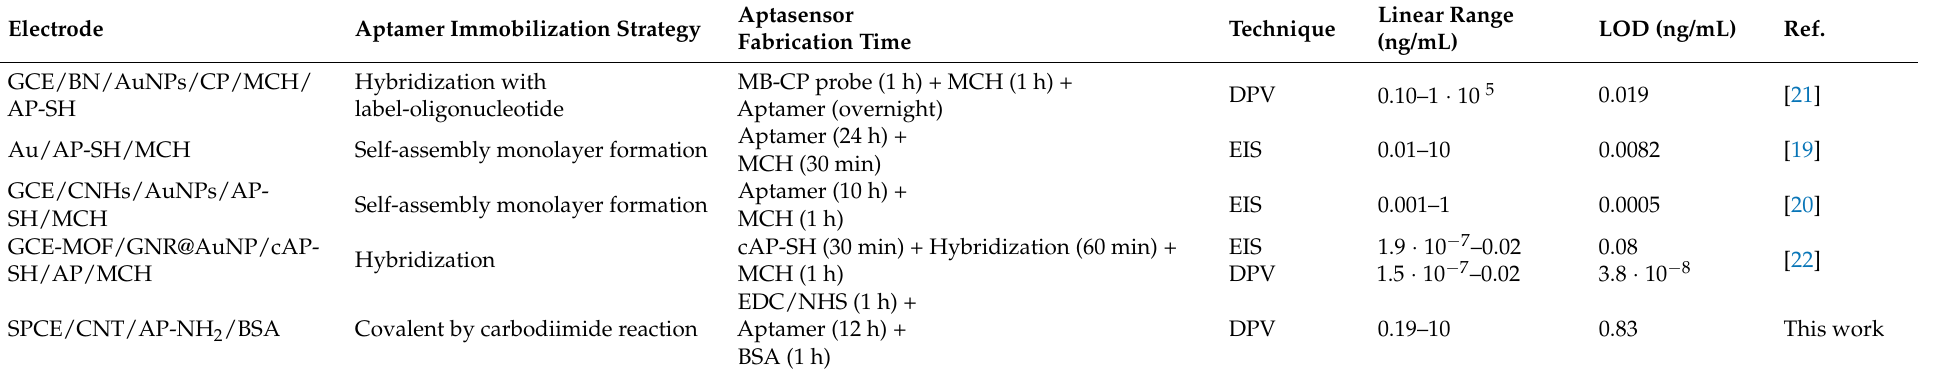
Table 2. Comparison of the performance of the proposed aptasensor with reported electrochemical